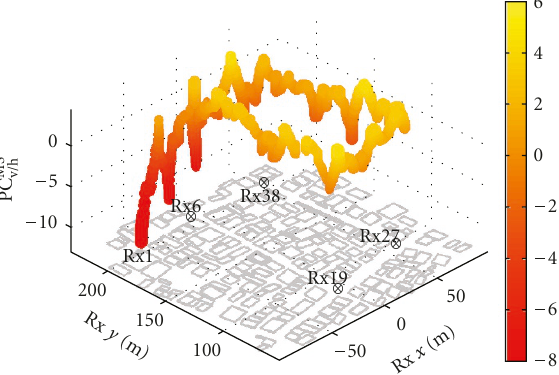
of the SCs Δ s = 20 (ca 3m). v